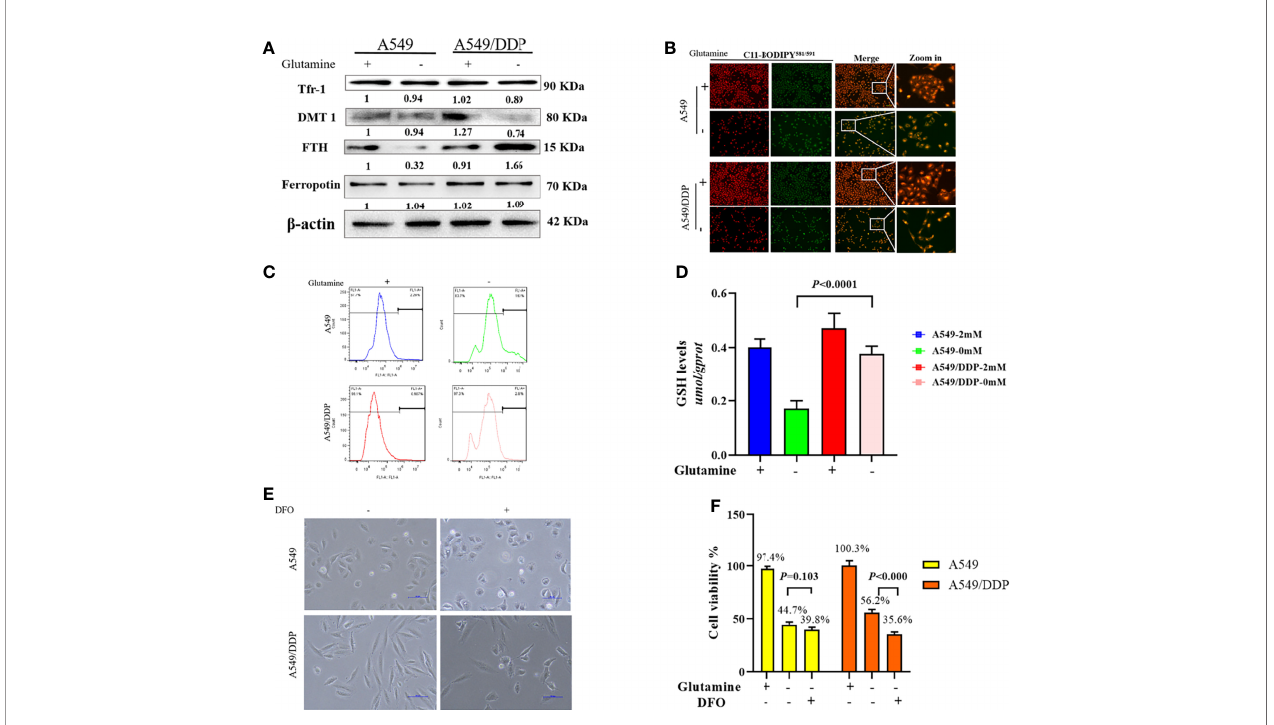
FIGURE 4 | A549/DDP cells reprogrammed iron metabolism and became vulnerable to DFO. (A) Blots of iron uptake and storage protein expression in A549 and A549/DDP cells cultured with (+) or without ( − ) glutamine for 48 h. b -actin served as a loading control. (B) Representative images of A549 and A549/DDP cells loaded with C11-BODIPY 581/591 and cultured with (+) or without ( − ) glutamine for 48 h. (C) ROS levels in A549 and A549/DDP cells cultured with (+) or without ( − ) glutamine for 48 h. (D) GSH concentrations in A549 and A549/DDP cells cultured with (+) or without ( − ) glutamine for 48 h. (E) Morphological observation of DFO treatment ’ s (100 m M; 48 h) effects on A549 and A549/DDP cells cultured with (+) or without ( − ) glutamine for 48 h. (F) Viability after DFO treatment (100 m M; 48 h) of A549 and A549/DDP cells cultured with (+) or without ( − ) glutamine for 48 h. All experiments were repeated at least three times, and results were expressed as mean ±